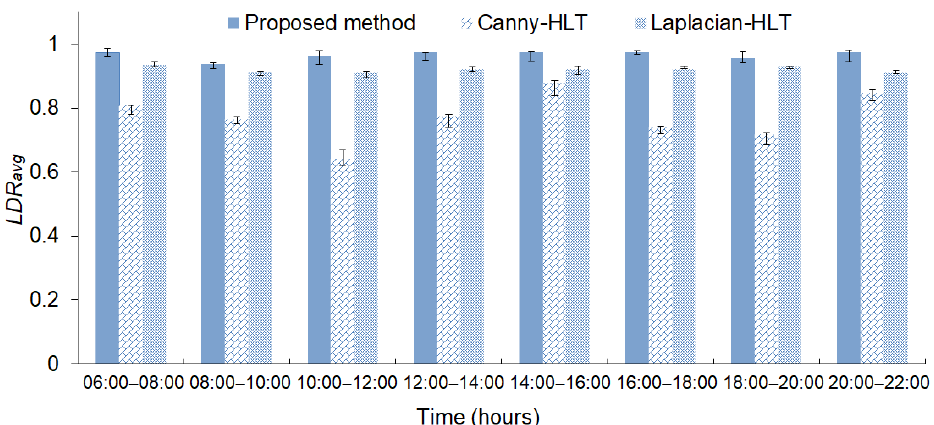
Figure 13. Comparison of the drip tape detection performance of the three methods at different time intervals within three days. Table 2. The performance evaluation results of different line detection methods in the guidance system of the